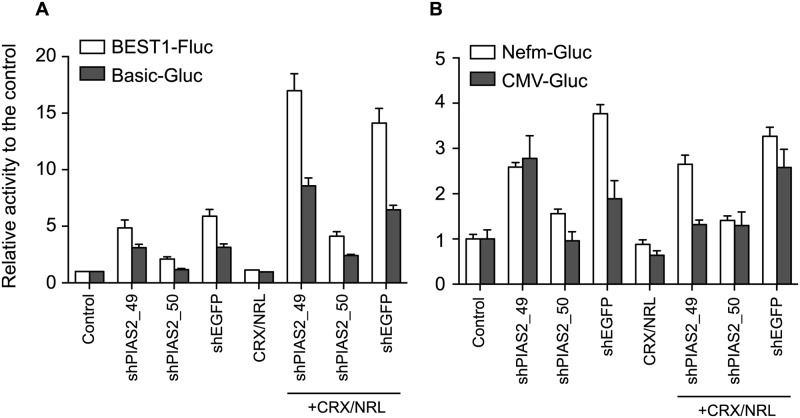
shRNA regulates the activity of the other promoter reporters.HEK293 cells were co-transfected with the indicated shRNAs with or without CRX and NRL expression vectors in the presence of BEST1-Fluc, Basic-Gluc (both in A), Nefm-Gluc, or CMV-Gluc (both in B). Two days after the transfection, Firefly and Gaussia luciferase activities were measured. As a control, 500 ng of empty pcDNA3 vector with 100 ng reporter vector was transfected into HEK293 cells. Relative activity was presented as the ratio to the control. Error bars are shown as SE.